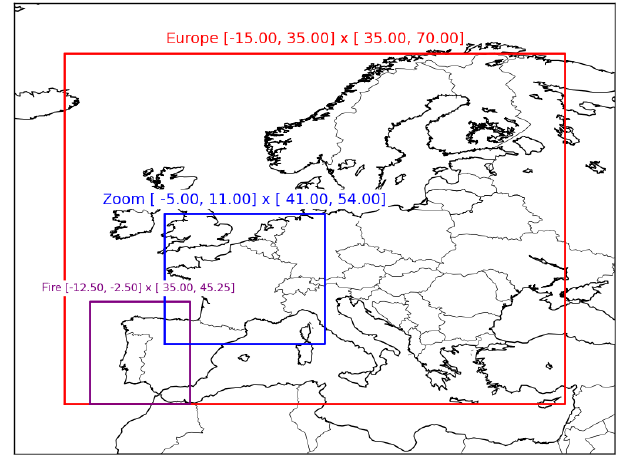
Figure 6. Illustration of different domains used for the assimilation runs. European domain (red rectangle), zoom domain (blue rectan- gle) and fire domain (purple